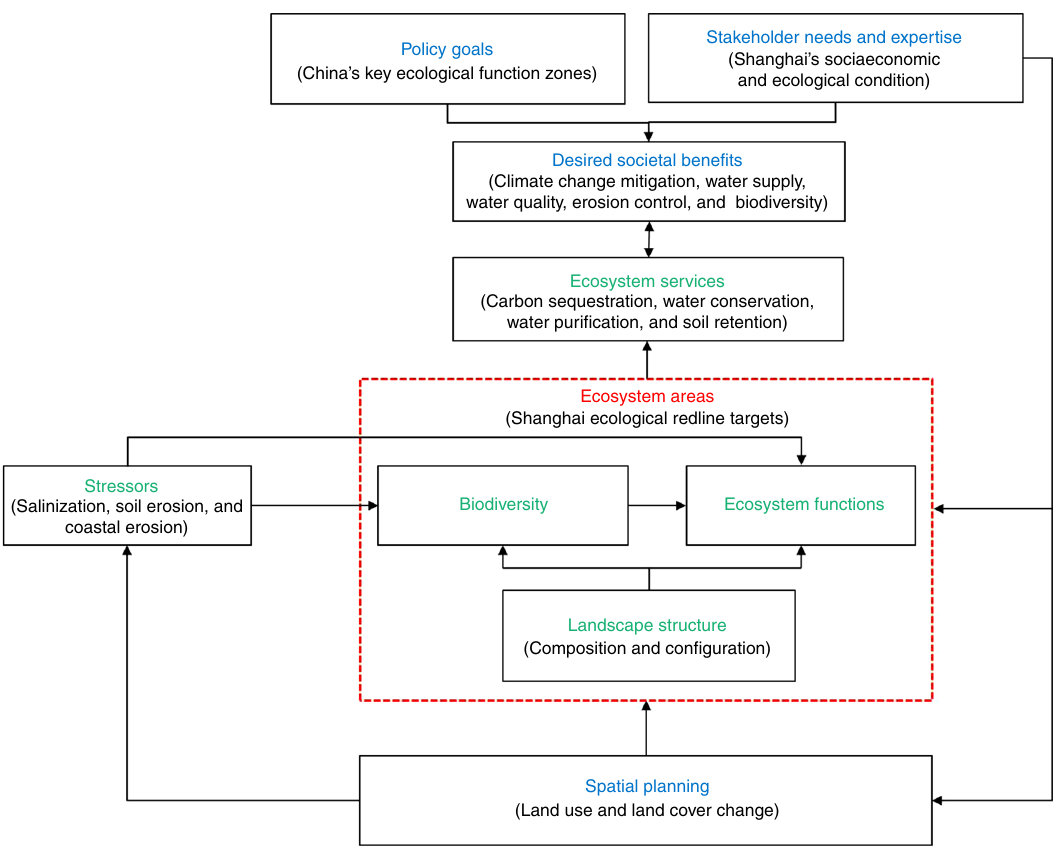
Fig. 1 Science – policy framework linking institutional and ecological information. Ecosystem services provisioning depends on biodiversity and ecosystem functions, which are in fl uenced by landscape structure and stressors (ecological criteria, green text). Spatial planning should manage ecosystem areas (spatial targets, red box/text) to sustain biodiversity and ecosystem functions (ecological health) by minimizing stressors and fragmentation. Ecosystem services assessments for planning should use policy goals and local stakeholder needs to select the desired ecosystem services to ground the analysis in the given decision-making context (socioeconomic criteria, blue text). Black text is the selected ecological and socio-economic criteria to determine the ecological redline areas for Shanghai Municipality. China ’ s Ecological Redline Policy aims to use spatial planning to safeguard ecological redlines areas (ERAs) to ensure the protection of key ecological function zones and ecologically fragile areas (vulnerable to stressors) to improve the living environment for people and